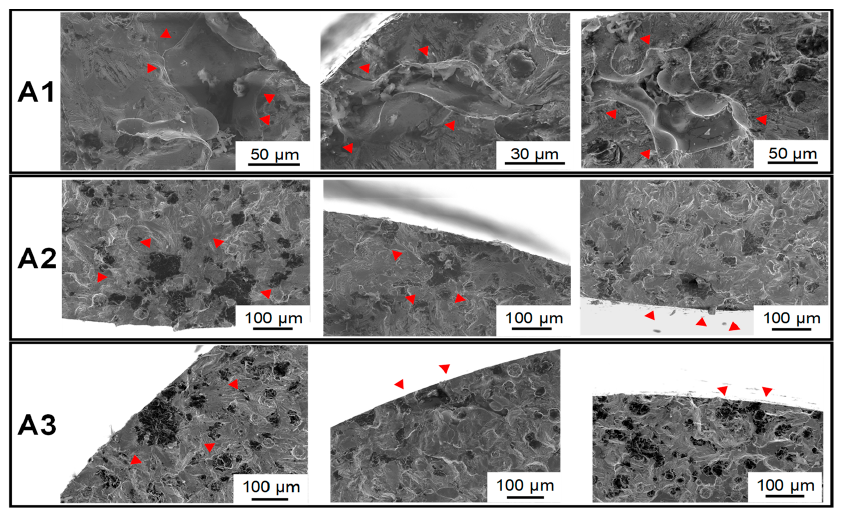
Figure 6. SEM pictures of Crack loci on fracture surfaces of broken specimens from alloys A1–A3.